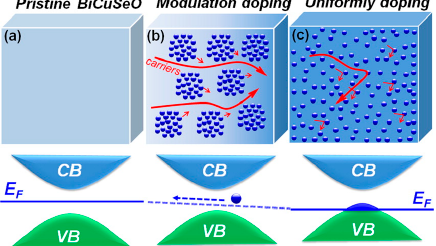
Figure 10. Three-dimensional schematic showing the band structures and Fermi energy levels for ( a ) the pristine BiCuSeO; ( b ) modulation doped Bi 0.875 Ba 0.125 CuSeO (50% BiCuSeO + 50% Bi 0.75 Ba 0.25 CuSeO); and ( c ) uniformly doped Bi 0.875 Ba 0.125 CuSeO. Reproduced (adapted) with permission from Reference [8]. Copyright 2014, American Chemical Society.